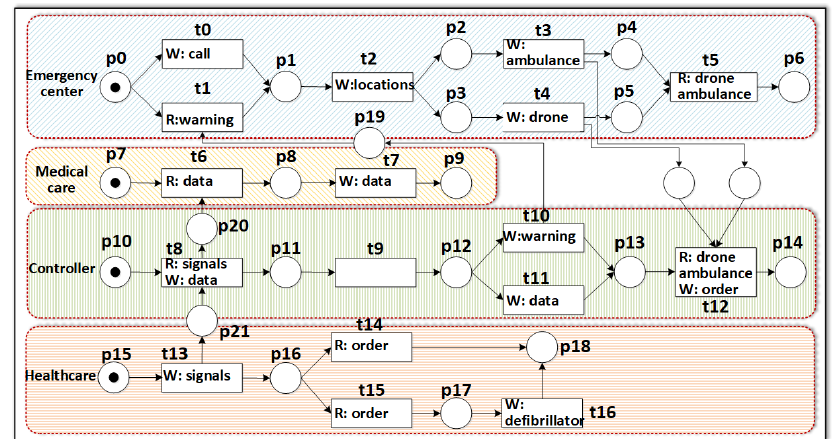
Figure 11. A PD-net that models a health-care cyber-physical system. Table 3. Transitions and their meanings.